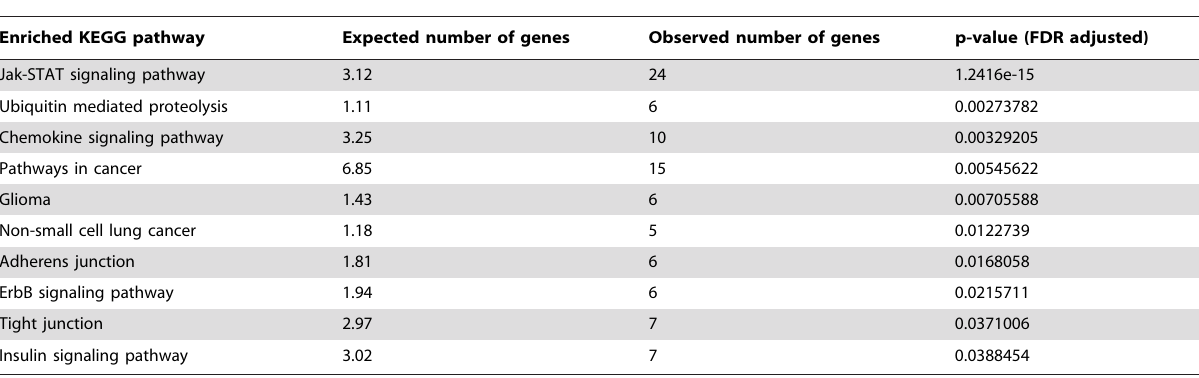
Table 2. Significantly enriched KEGG pathways with respect to the integrated deregulated